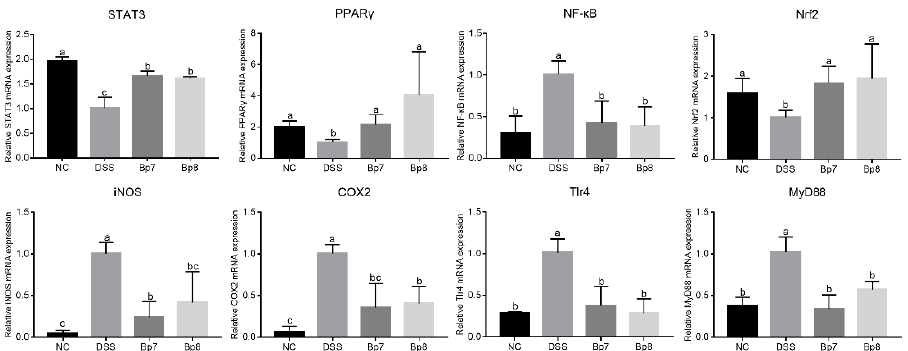
Figure 6. Influence of Bp7 and Bp8 intervention on the mRNA transcription of gene-related NF- κB pathway ( n = 8). The different letters represent significant differences between experimental groups ( p < 0.05).